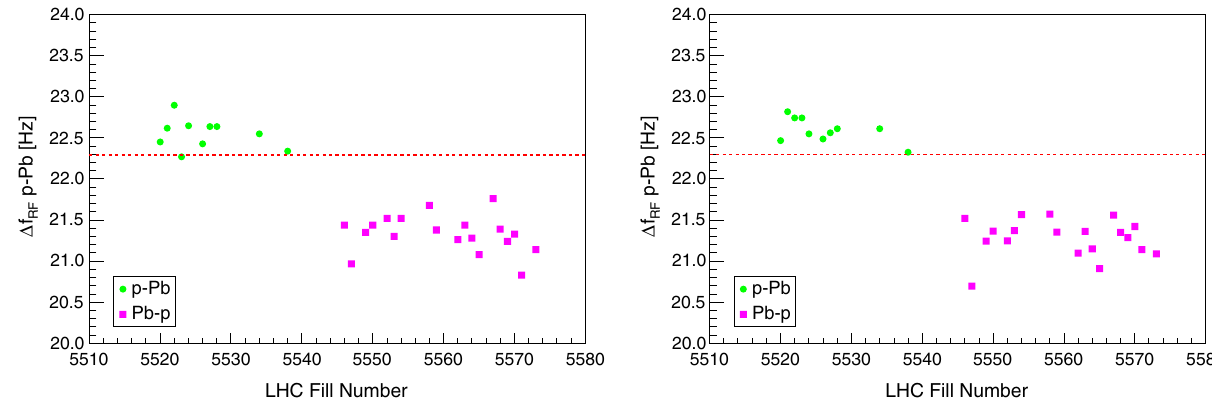
FIG. 13. Time dependence of the frequency difference Δ f of protons and lead ions at 6 . 5 TeV = c as a function of the LHC fill number rf in 2016. For the figure on the left, the frequency is reconstructed after the rf cogging (method B), for the figure on the right before rf cogging (method A). The red dotted line is the frequency difference corresponding to an energy of 6 . 5 TeV =